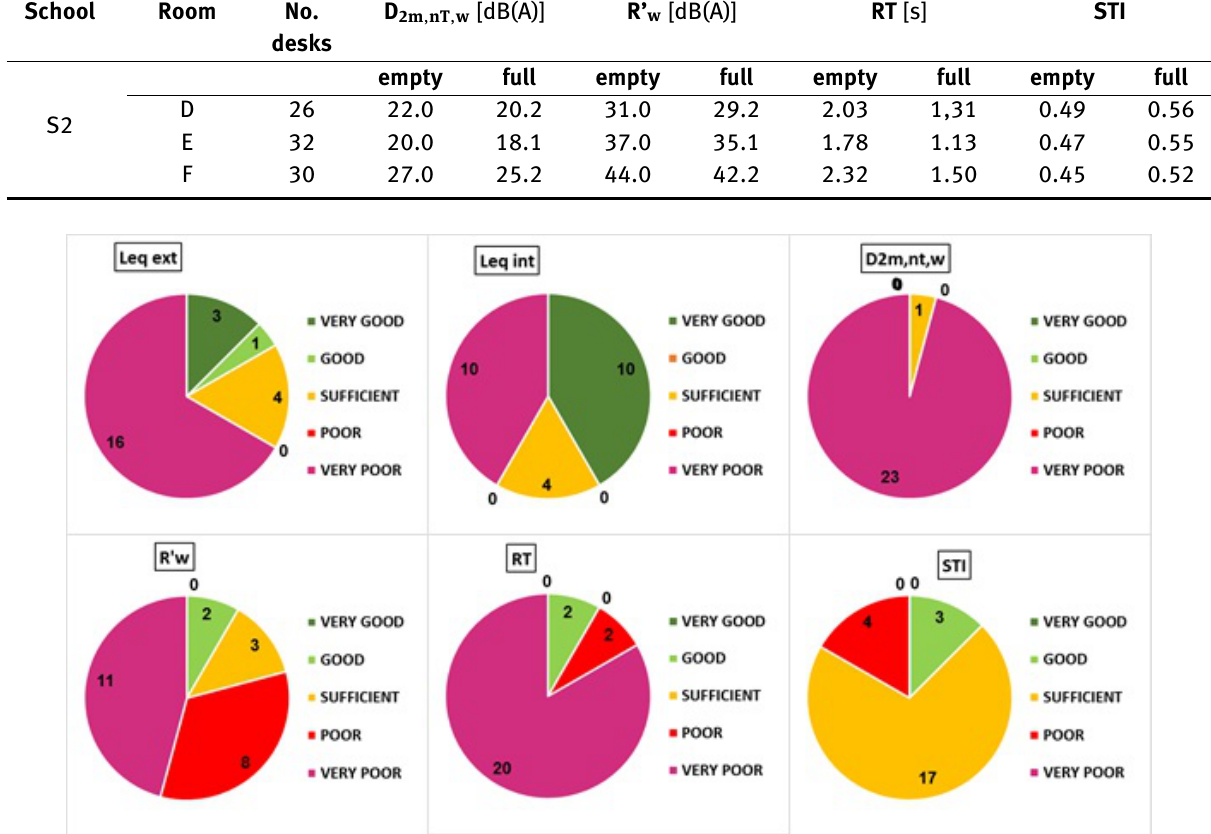
Table 10: Comparison between empty classroom condition (measured parameters) and full-occupied classroom condition (simulated pa- rameters).